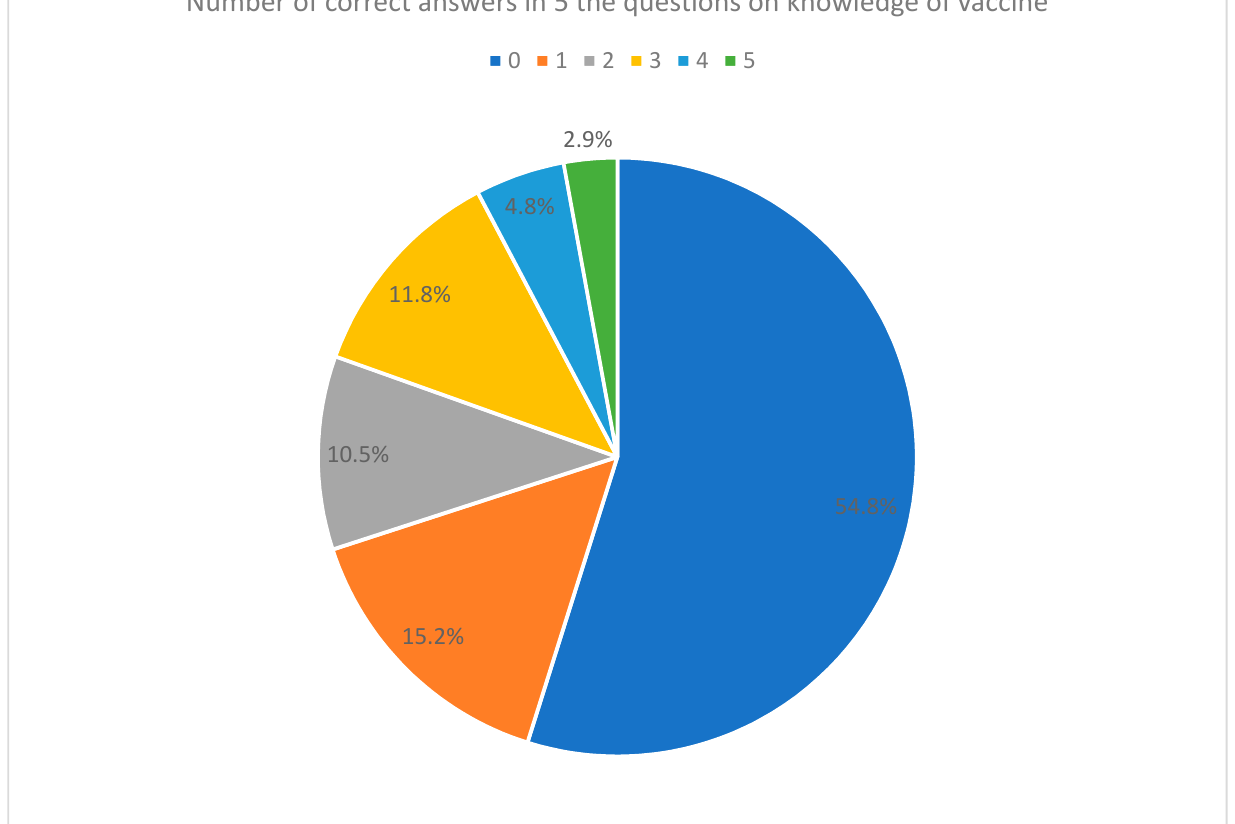
Figure 3. Pie chart on score distribution of knowledge about vaccine (number of correct answers).